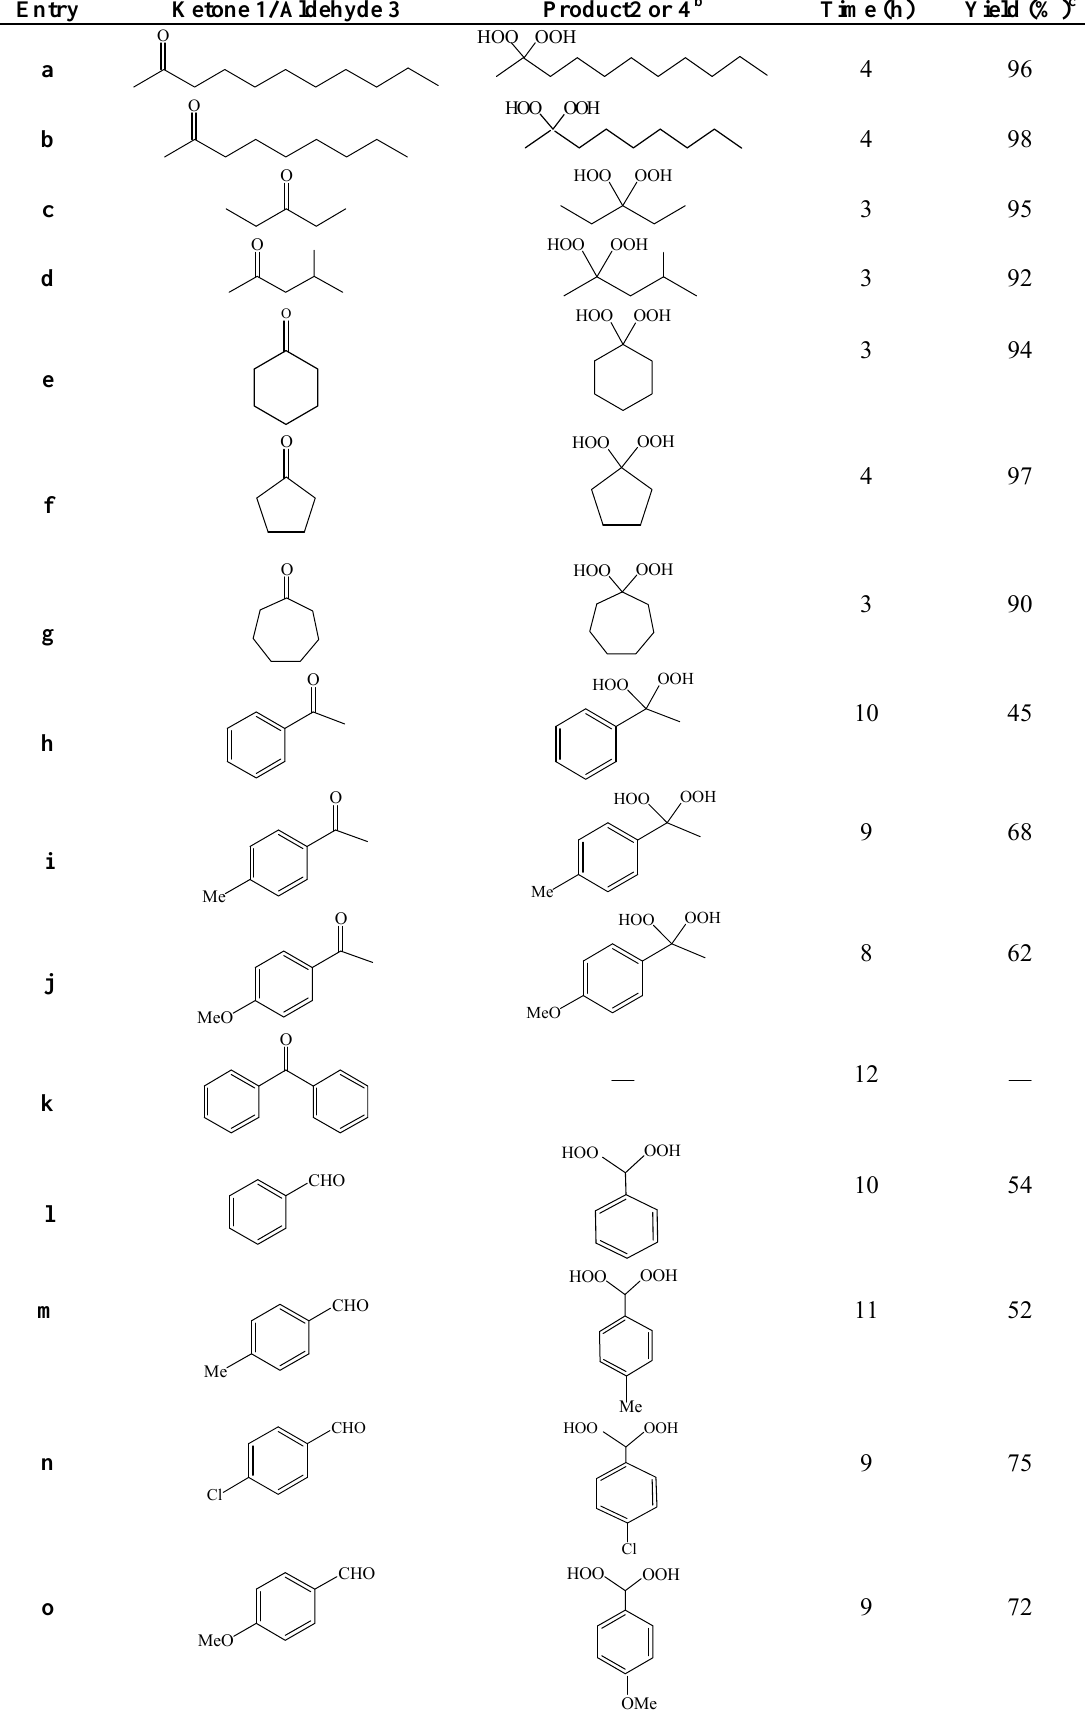
Table 2. Synthesis of gem -dihydroperoxides with SrCl Entry Ketone 1/ Aldehyde 3 Product2 or 4